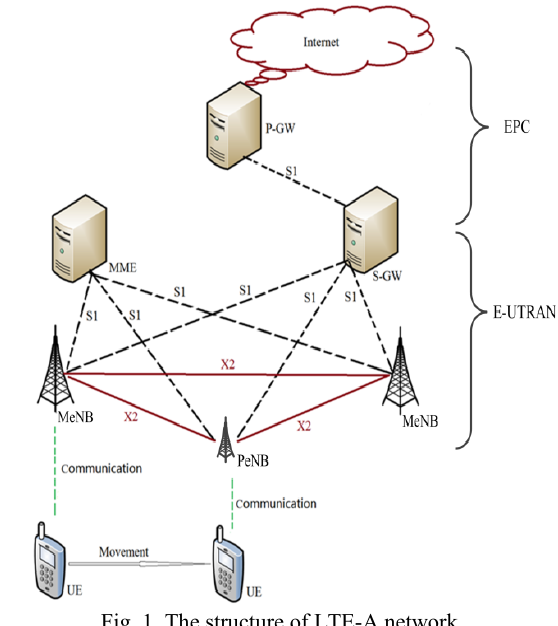
Fig. 1. The structure of LTE-A